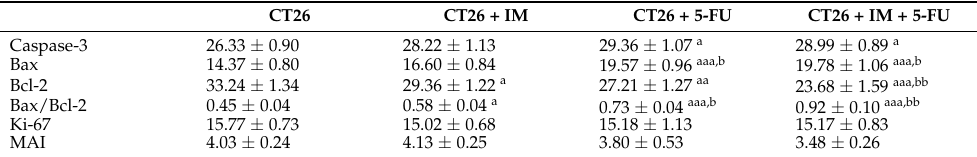
Data are expressed as means ± S.E.M. Significantly different, a p < 0.05, aa p < 0.01, aaa p < 0.001 vs. CT26, b p < 0.05, bb p < 0.01 vs. CT26 + IM. Data from IHC analysis represent the expression of proteins quantified as the average percentage of antigen-positive area in standard fields (0.5655 mm 2 ) of tumour hot spot areas. At least 60 images for one marker were analyzed. MAI represents the number of mitoses per ten high power fields ( × 400) in each evaluated tumour. Within the histopathological analysis, we have evaluated a total of 14 tumours/allografts (control group, n = 4; IM, n = 4; 5-FU, n = 2; IM + 5-FU, n = 4). The assessing of necrosis/all tumour area ratio (N/A) showed following data: CT26-20.6%, CT26 + IM- 31.1%, CT26 + 5-FU-0.0%, CT26 + IM + 5-FU-12.2%. Histopathological evaluation of CT26 tumours did not reveal any changes in MAI between control and treated groups (Table 3); this result is in accordance with the data gained from the immunohistochemical analysis (Ki67 marker).